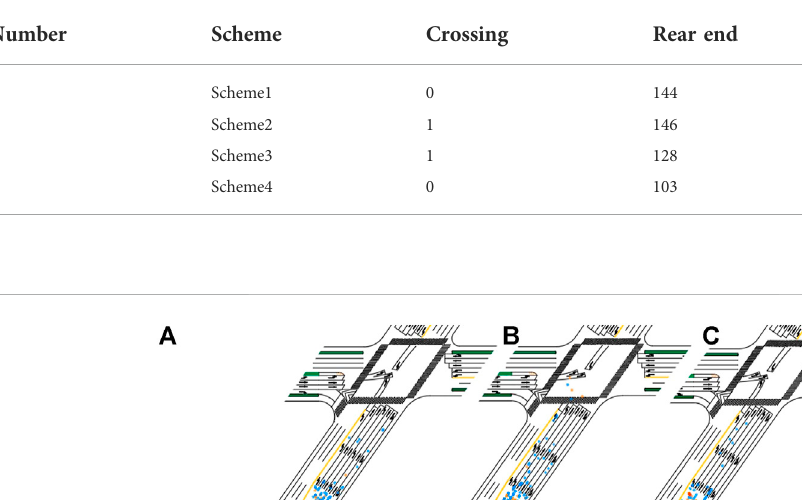
TABLE 4 Safety analysis of four simulations by SSAM.